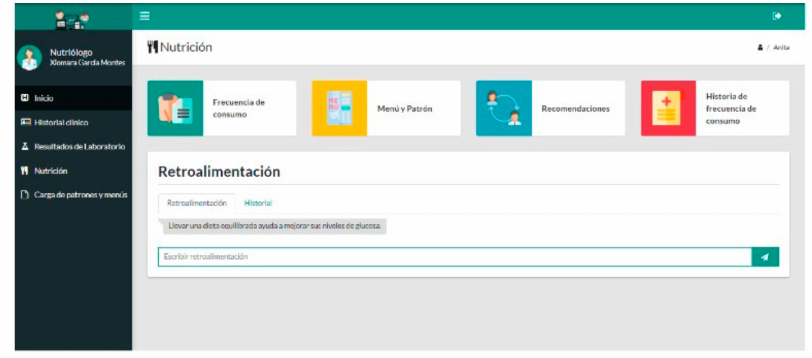
Figure 30. Nutritionist application interface: Recommendations in the food field.